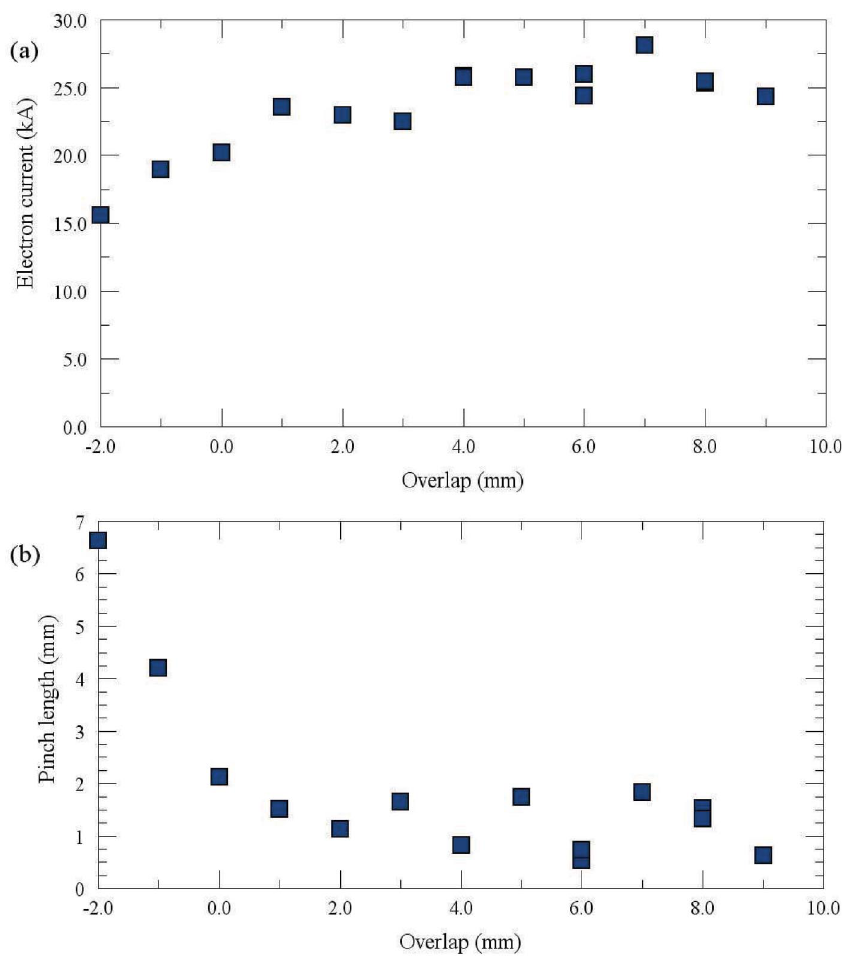
(cid:5) 5 : 0 mm . with a fixed cathode inner radius R ac c